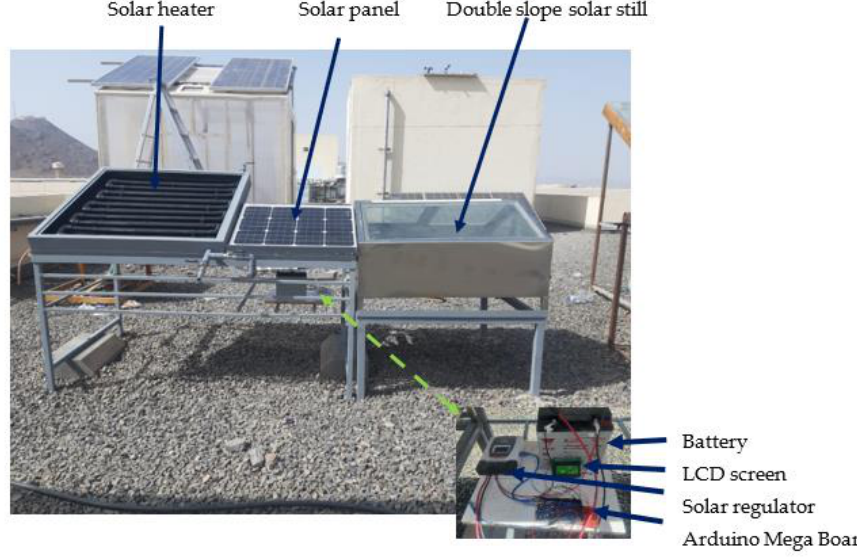
Figure 8. A photo of the smart hybrid solar heater–solar still desalination unit.